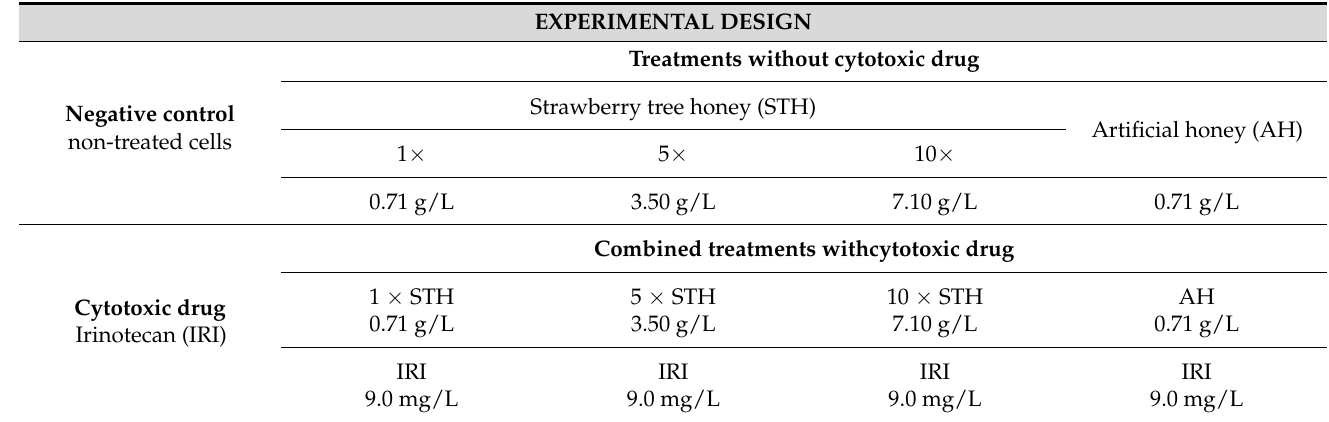
Table 7. Description of experimental groups and treatments. In vitro exposure of blood samples to the selected concentrations of all of the tested compounds. EXPERIMENTAL